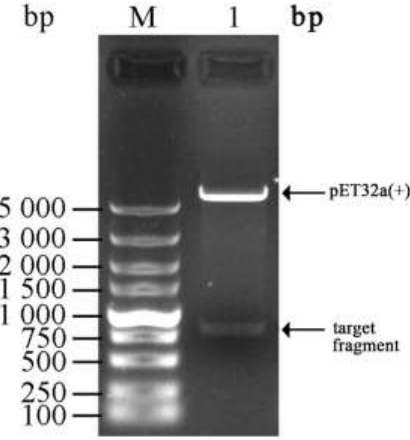
Figure 5. Confirmation of the expression vector by restriction enzyme digestion M: DL5000 DNA marker; 1: The products of the pET32a(+)- ChiKJ406136 vector by restriction enzyme digestion.